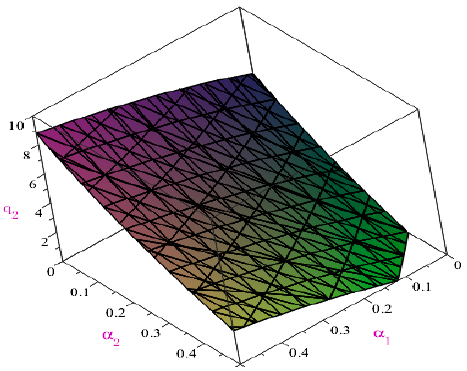
∗ with α 1 and α 2 ( α 1 ≤ 0.5, α 2 ≤ 2